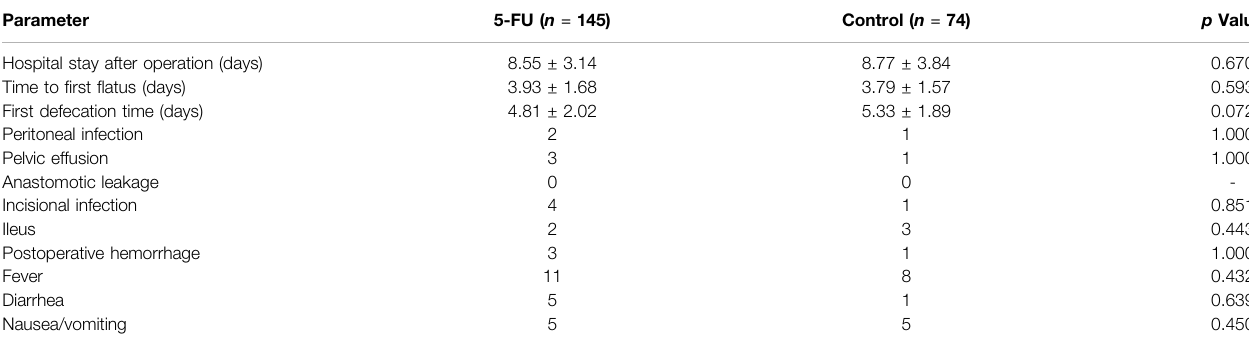
TABLE 2 | Postoperative complications, length of hospital stay and adverse effects in patients.